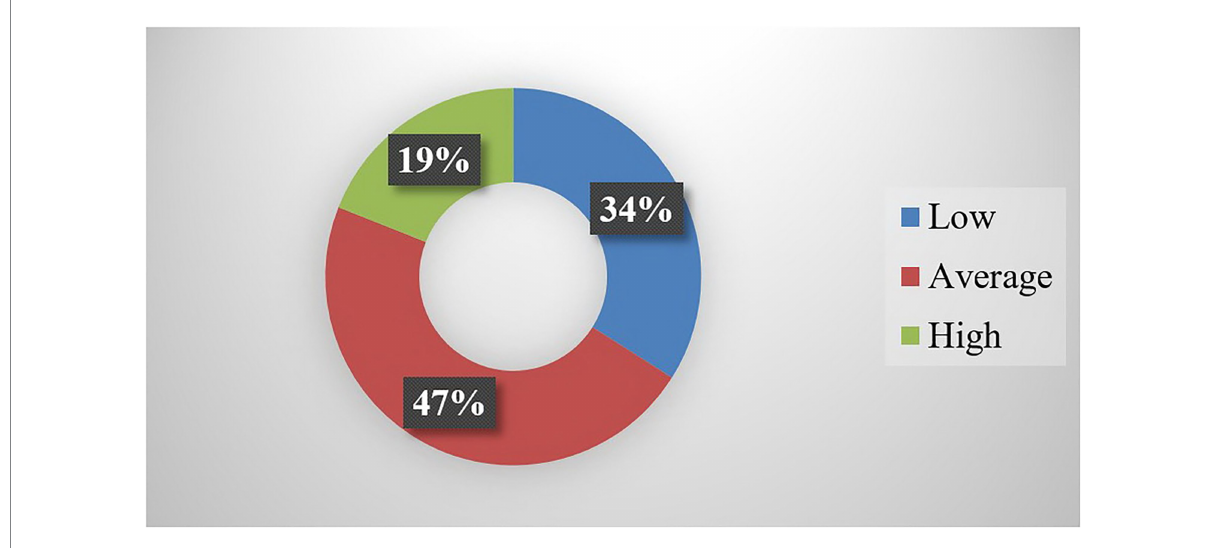
FIGURE 3 Students communication